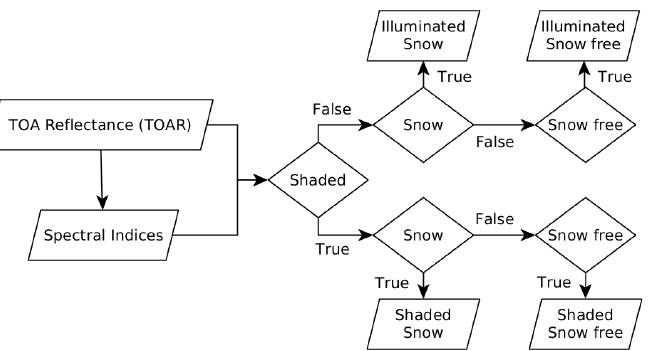
Figure 5. Workflow for the selection of local endmembers within a multispectral image. The spectral indices are described in Table 2. Table 2. The spectral indices that are used for the local endmember selection. Reflectances of five spectral bands are used: r 560 , r 650 , r 860 , r 1610 and r 2200 , which represent the reflectance of green, red, NIR and two types of SWIR light. The subscript indicates their wavelengths in